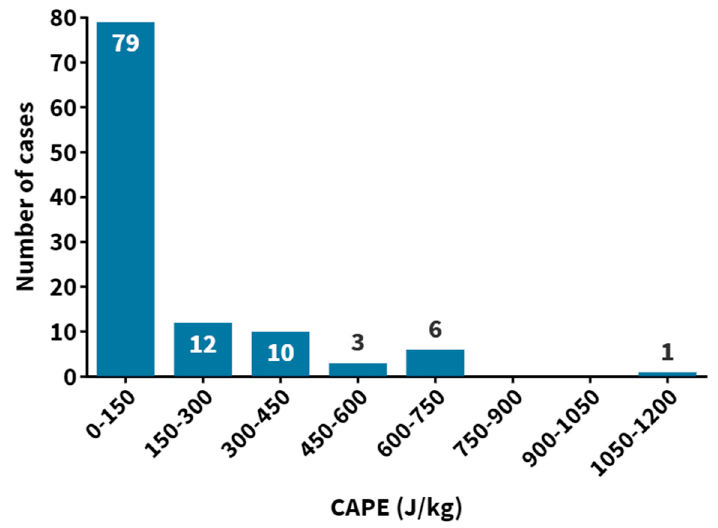
Figure 6. CAPE values for all the 57 high ozone episodes that occurred in 2013–2019. Note, data from the 00Z and 12Z radiosondes launched during the high ozone day were obtained. Out of 114 launches, data from 3 launches were not available for analysis.